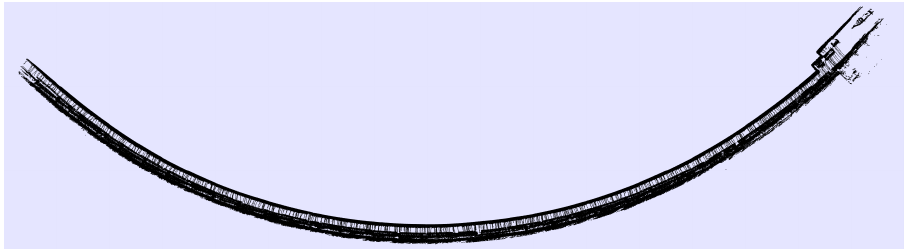
Figure 8. Reconstruction of the tunnel SPS during a long survey. In this case, the corridor was completely monotonous, excluding the right section.